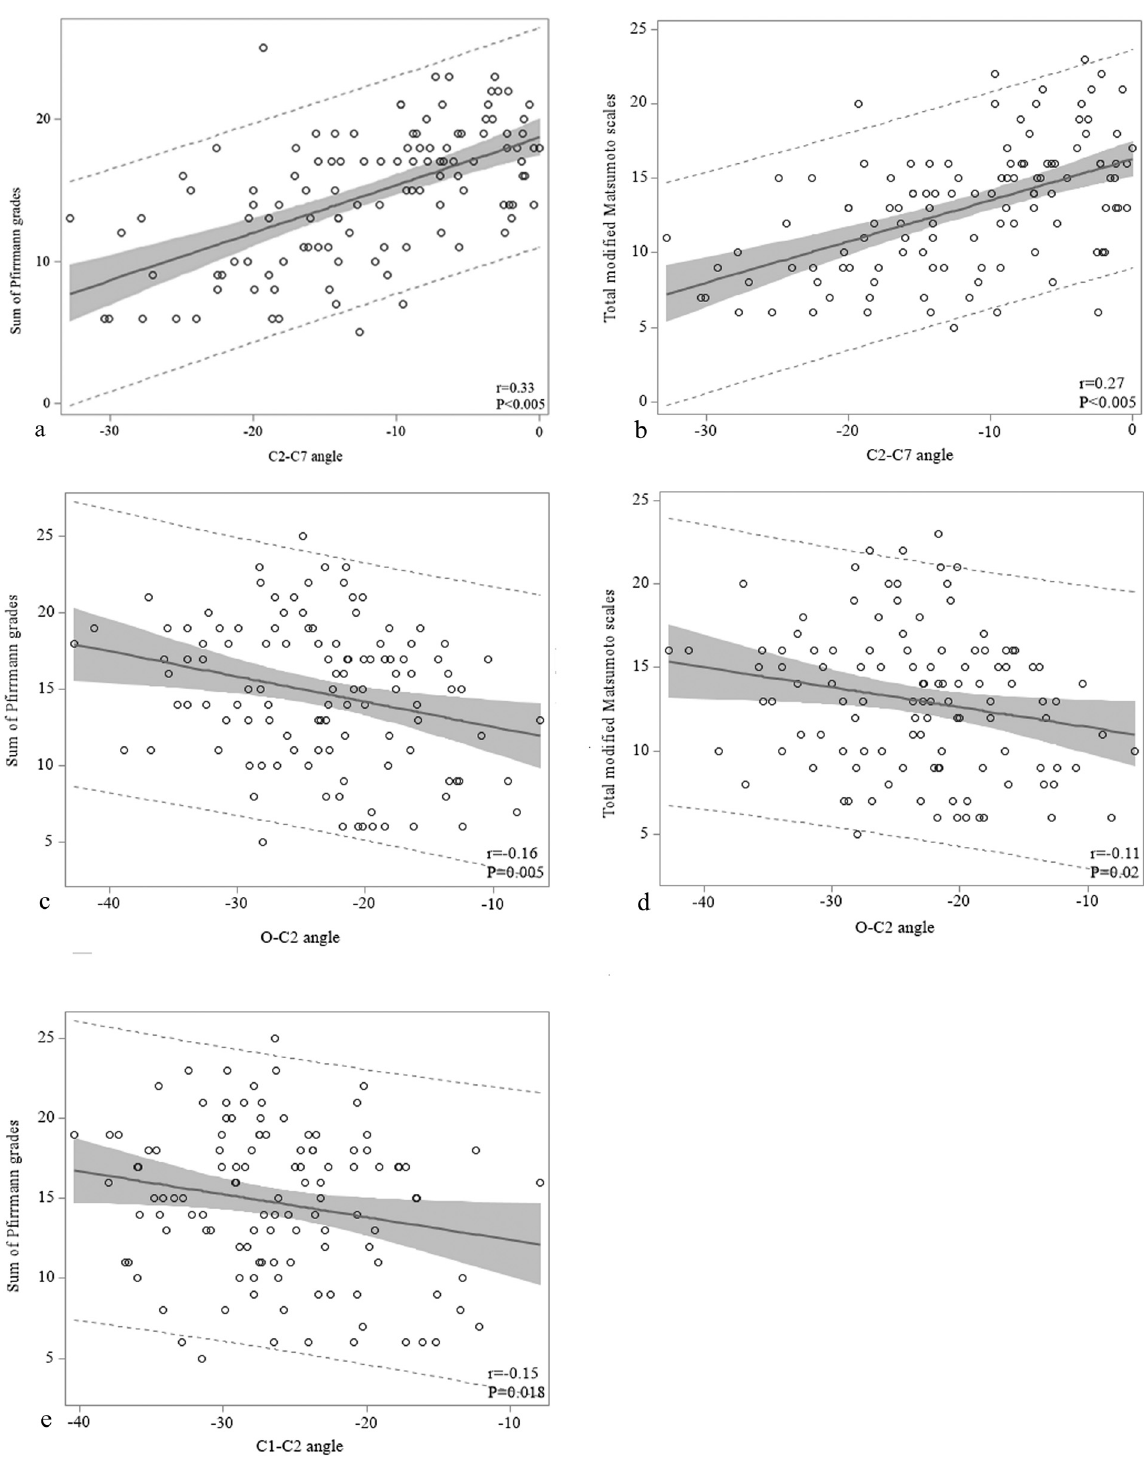
Figure 3: Correlation between sagittal angles of the cervical spine and the degree of cervical disc degeneration. ( a ) The C2 – C7 angle and sum of P fi rrmann grades; ( b ) the C2 – C7 angle and total modi fi ed Matsumoto scales; ( c ) the O – C2 angle and sum of P fi rrmann grades; ( d ) the O – C2 angle and total modi fi ed Matsumoto scales; and ( e ) the C1 – C2 angle and sum of P fi rrmann